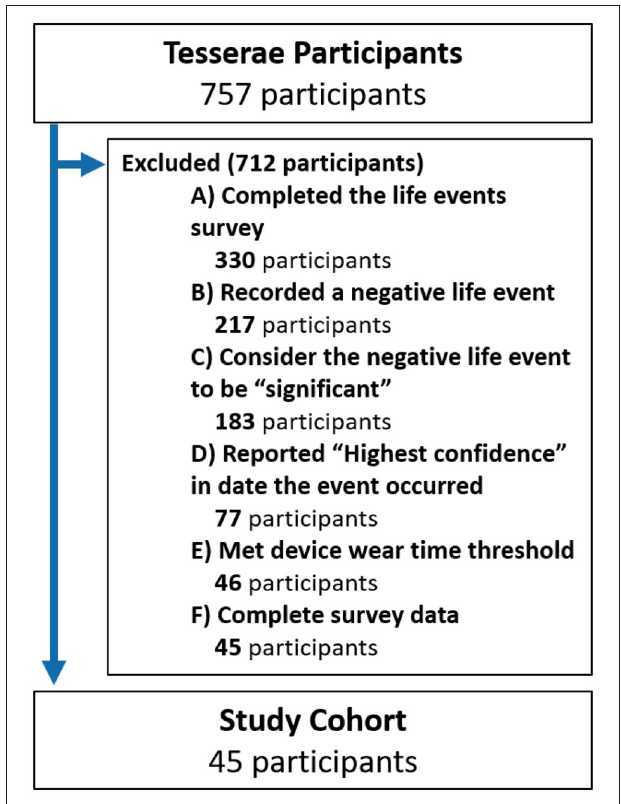
FIGURE 1 | Consort